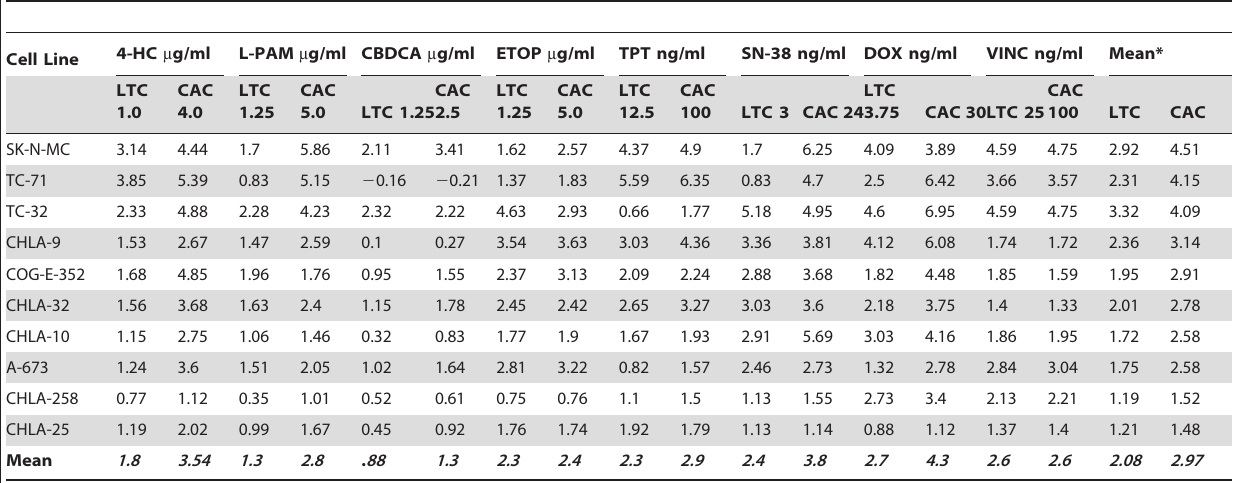
lines was examined for each drug separately. Given that data from the same cell line were potentially correlated, those analyses were performed using the method of generalized linear equations with robust standard errors. Estimated difference in logs of cell kill and its 95% confidence interval (95% CI) are presented for each drug (Table 2). All P values reported are two-sided. Analyses were performed using STATA version 9.2. The concentration of drug that was cytotoxic and/or growth inhibitory for 99% of cells (IC 99 ) (Table 3) was calculated using the software ‘‘Calcusyn’’ (Biosoft, Cambridge, UK). DNA Fingerprinting Short-tandem-repeat (STR) genotyping was performed to confirm the molecular identity of each cell line (Table S2) by Table 2. The log cell kill achieved at the lower tested concentration (LTC) and clinically achievable concentration (CAC).